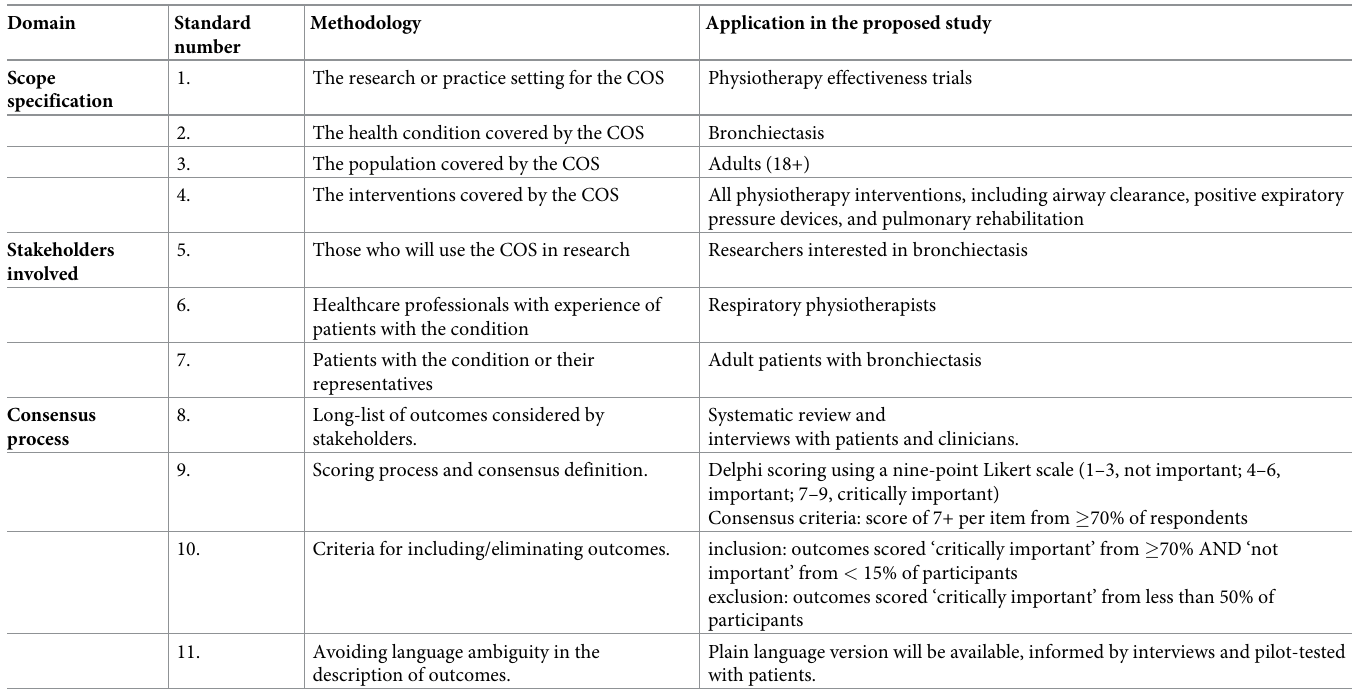
Table 1. Developing COS process based on the COMET COS-STAD